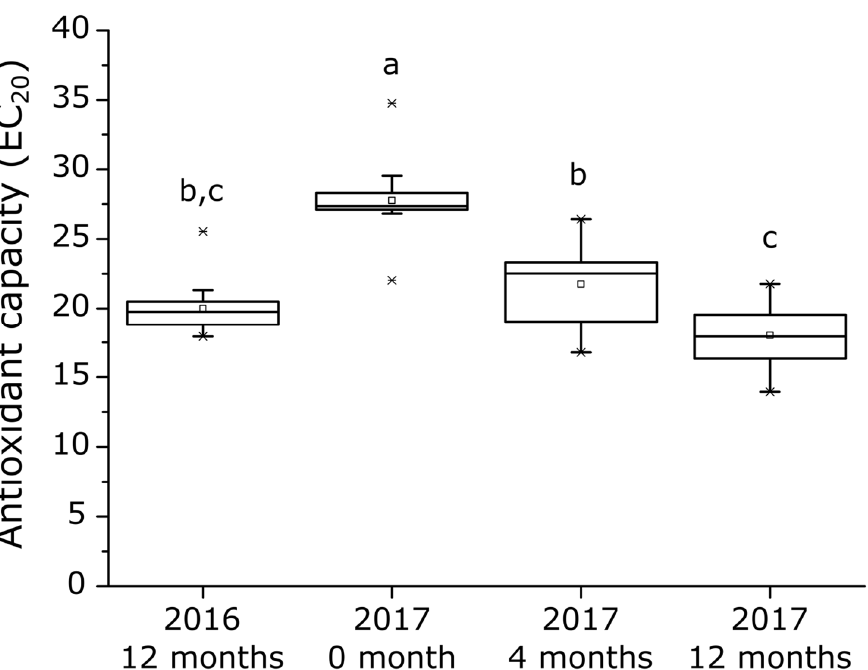
Figure 1. Antioxidant capacity of wines (EC 20 ) according to the vintage (2016, n = 14, and 2017, n = 42) and the on-lees barrel aging duration. Box plots represent median, first, and third quartile (Q1, Q3); whiskers represent 1.5 times interquartile ranges (Q1–Q3); squares visualize mean and cross minimal and maximal values. Different letters indicate significantly different groups determined using ANOVA and Tukey test ( p -Value < 0.05).